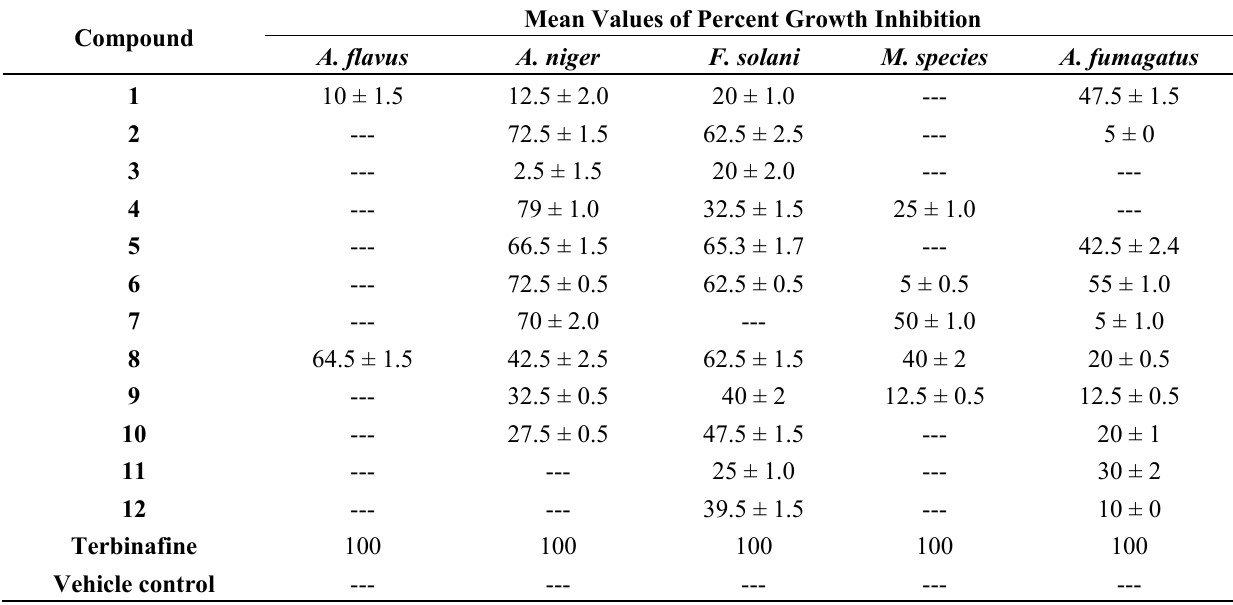
Table 5. In vitro antifungal activity of synthesized guanidines and standard drug.